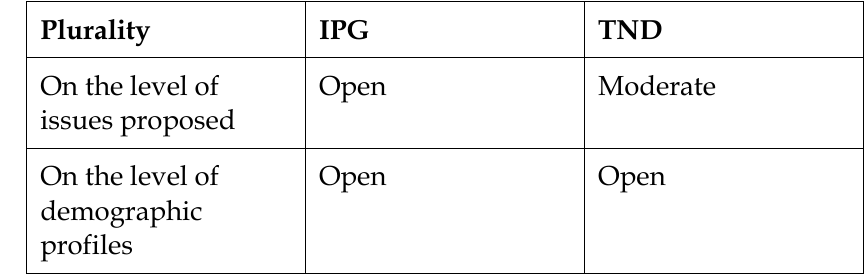
Table 3: The Dimension of Outcome on the IPG and TND Online